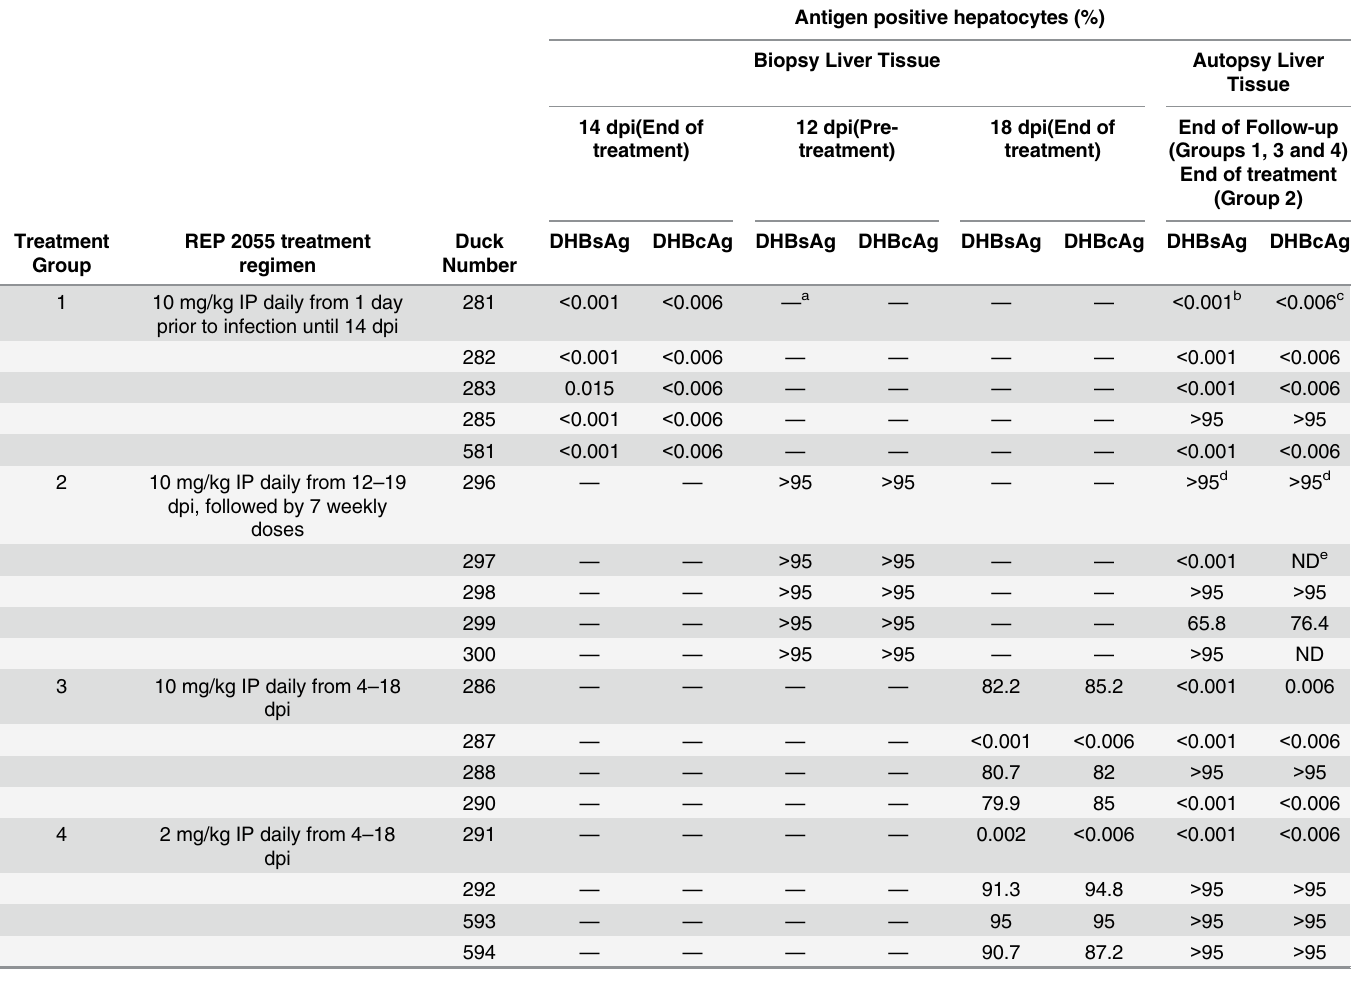
Table 1. In vivo Experiment 1: Detection of DHBsAg and DHBcAg positive hepatocytes in liver tissue.